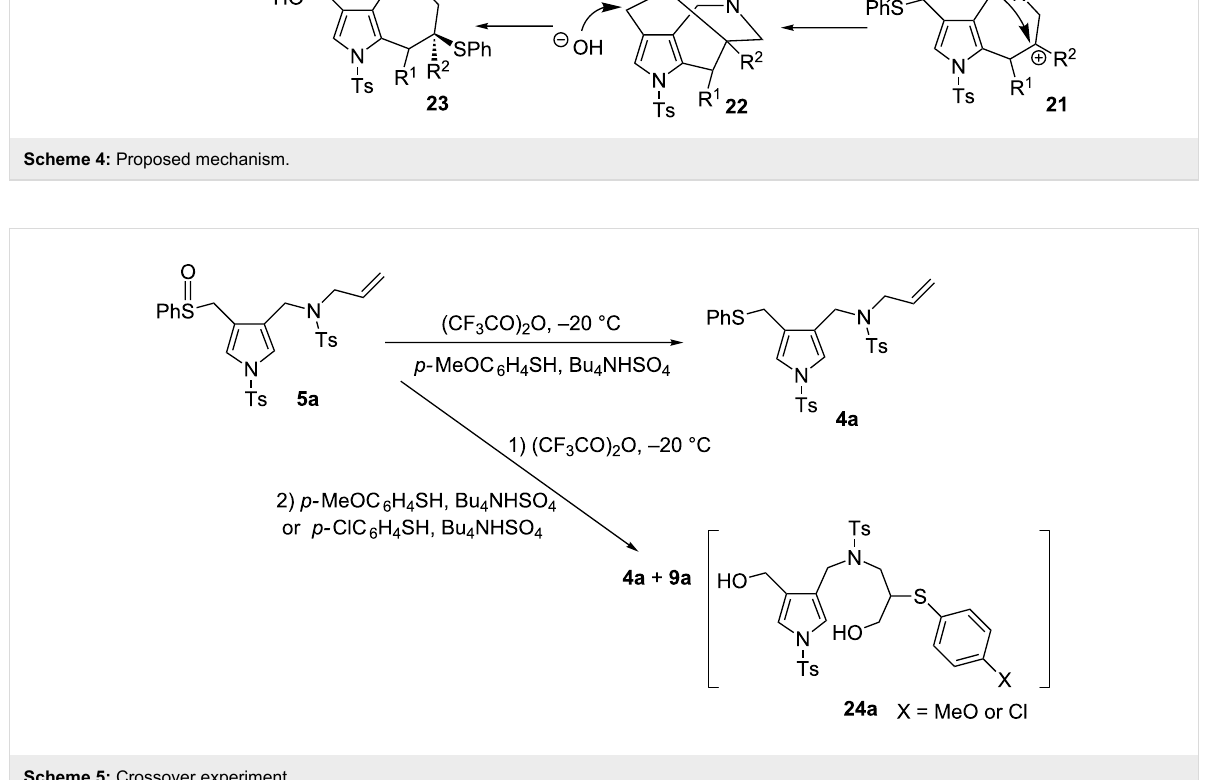
Scheme 4: Proposed mechanism.